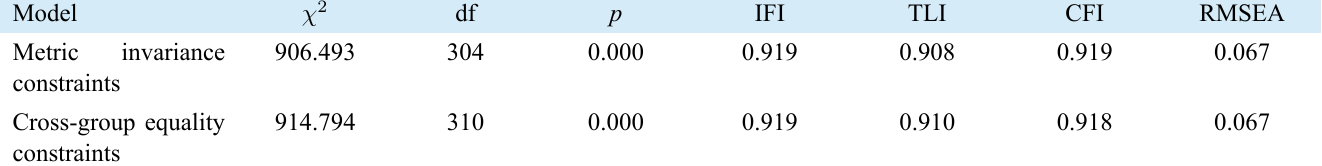
TABLE 5. Comparison of the fit between the cross-group constraints model and the base model between groups. Model Metric invariance constraints